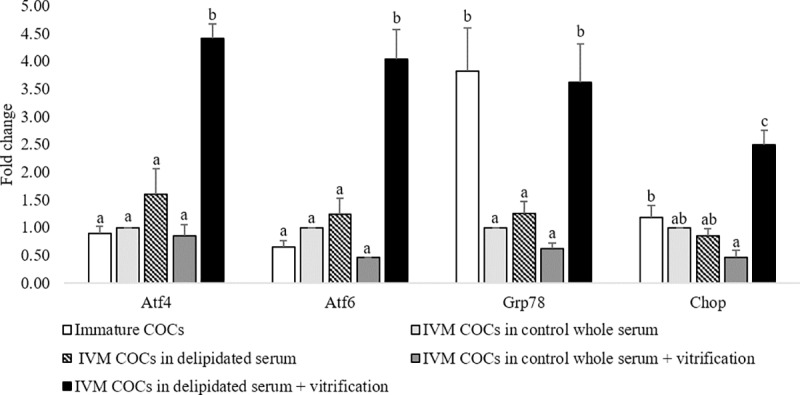
Expression of endoplasmic reticulum (ER) stress genes induced in cumulus oocytes complexes (COCs) submitted to in vitro maturation (IVM) in whole or delipidated serum with subsequent vitrification.Total RNA was extracted from denuded COCs, and expression of ER stress marker genes (ATF4, GRP7878, ATF6 and CHOP10) was determined by qPCR. Gene expression of 5 experimental groups, interaction was found when COCs were matured in delipidated serum and subsequently vitrified. Within the same gene, different letters indicates significant differences (P< 0.05). Mean ± SEM is expressed as fold change compared with calibrator sample (control whole serum).